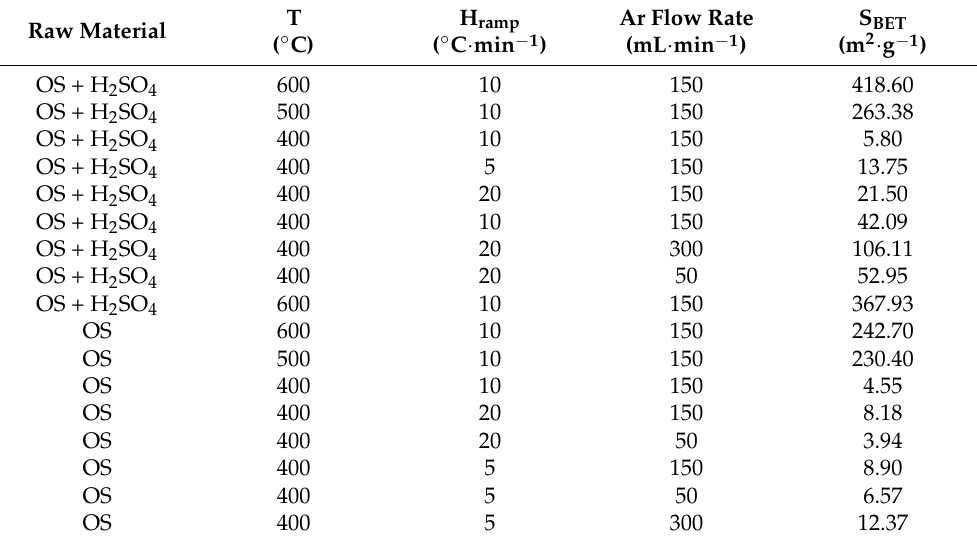
Table 3. Specific surface of the biochars obtained under different pyrolysis conditions.